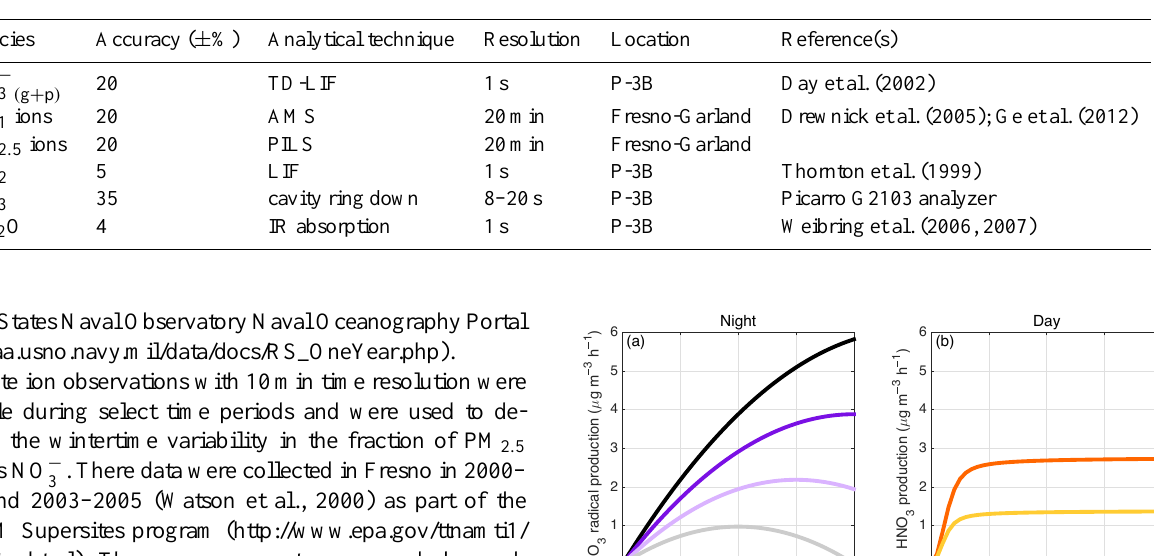
0 NO 2 (ppb) Figure A2. Panel (a) : nighttime NO 3 radical production (µgm − 3 h − 1 ) versus NO 2 (ppb) under four O x conditions: 50ppbO x (black), 40ppbO x (purple), 30ppbO x (violet), and 20ppbO x (gray). The temperature is 282K and NO 3 radical pro- duction is scaled by two, i.e., all NO 3 reacts with NO 2 and N 2 O 5 hydrolysis is rapid compared to NO 3 formation. Panel (b) : daytime production of HNO 3 (µgm − 3 h − 1 ) as a function of NO 2 computed with an analytical model at NO:NO x = 0 . 3 and VOCR = 4s − 1